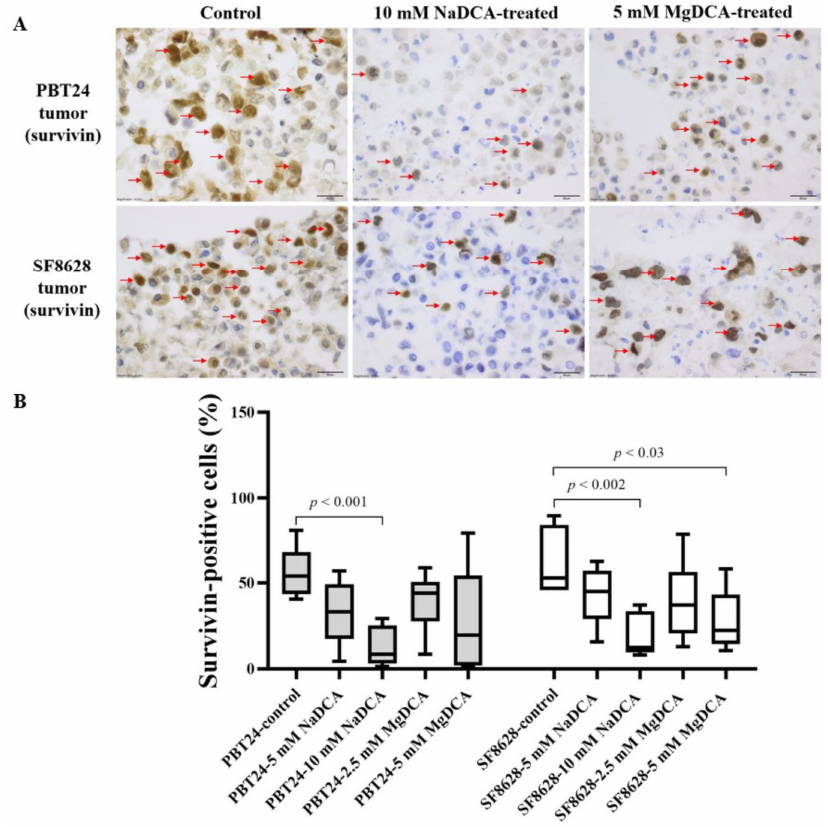
Figure 7. Immunohistochemical expression of survivin in control and DCA-treated PBT24 and SF8628 tumors. ( A ) Dark brown nuclei indicate survivin-positive cells (red arrows). The magnification is 40 × , scale bar is 20 µ m. ( B ) The percentage of survivin-positive cells in PBT24 and SF8628 tumors.